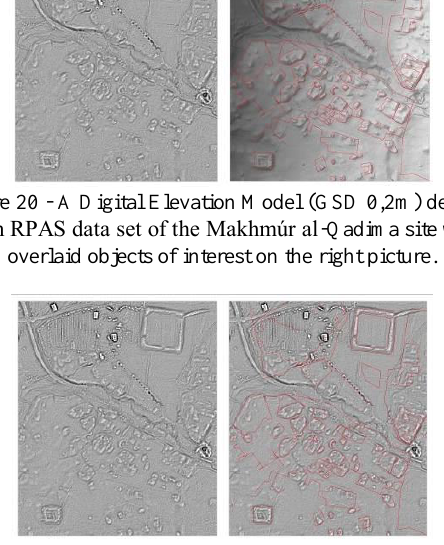
Figure 21 - A difference Digital Elevation Model (GSD 0,2m) derived from the RPAS DEM of the Makhmúr al-Qadima site with overlaid objects of interest on the right picture.